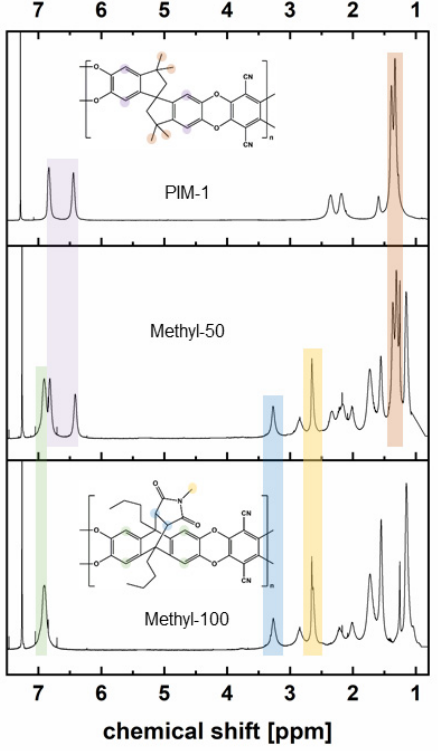
Figure 5. 1 H-NMR spectra of PIM-1, methyl-50 and methyl-100.